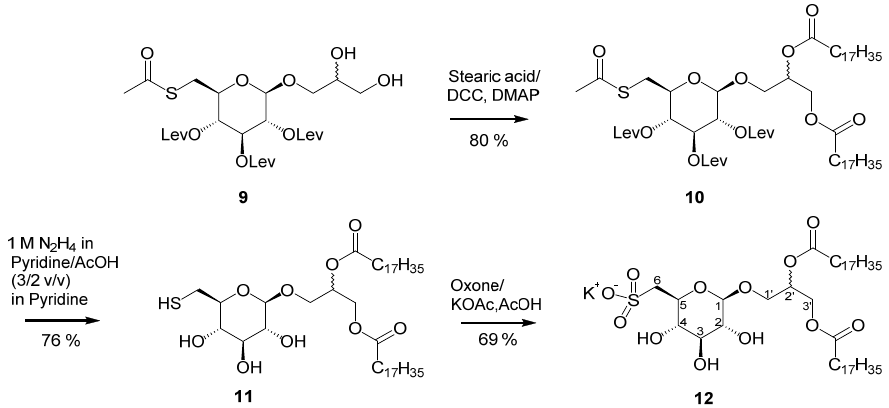
Scheme 2. Synthesis of 1,2-distearoyl-3- O -[ β - D -sulfoquinovosyl]-( R / S )-glycerol (SQDG). Conversion of D -glucose to the K + form of 1,2-distearoyl-3- O -[ β - D -sulfoquinovosyl]-( R / S )-glycerol with 10% overall yield.